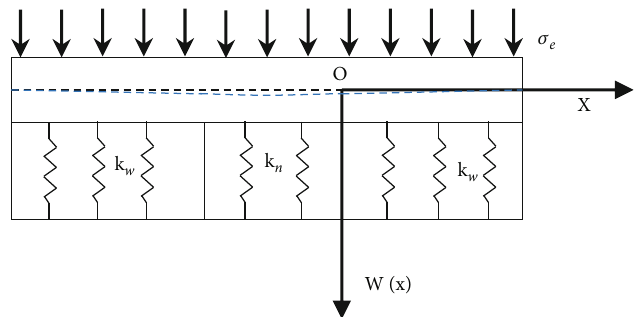
Figure 2: Mechanical model of roof in drainage area.